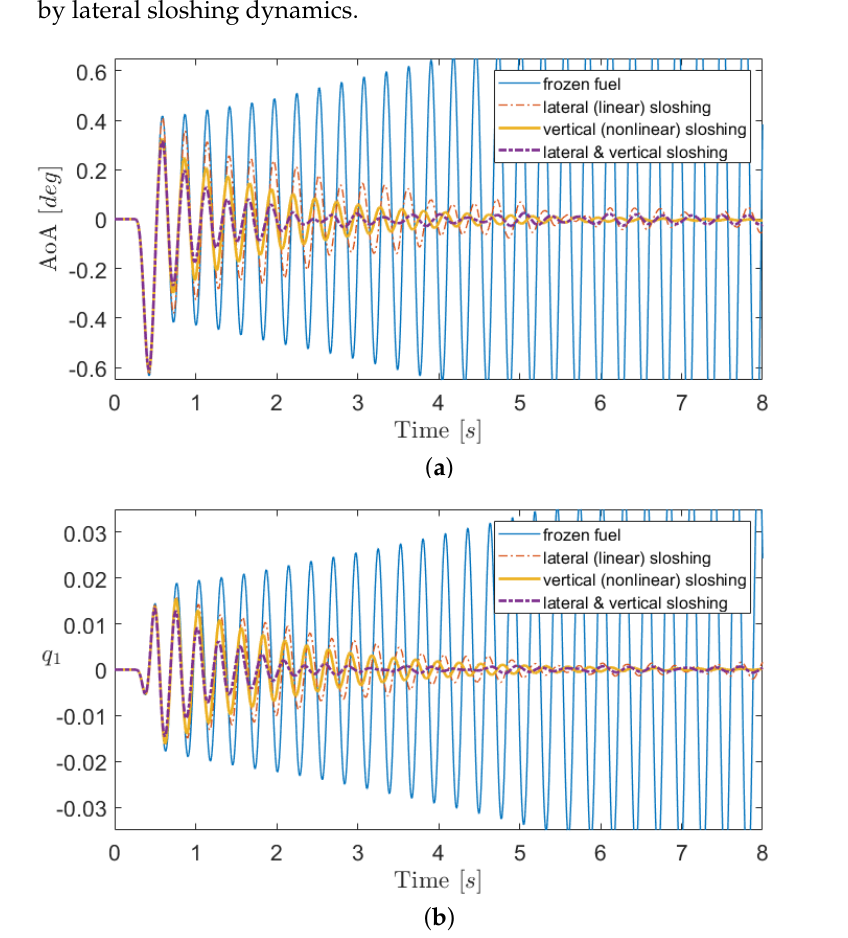
= 0.2m/s—Test Case 2. ( a ) Local angle of attack. ( b ) First a